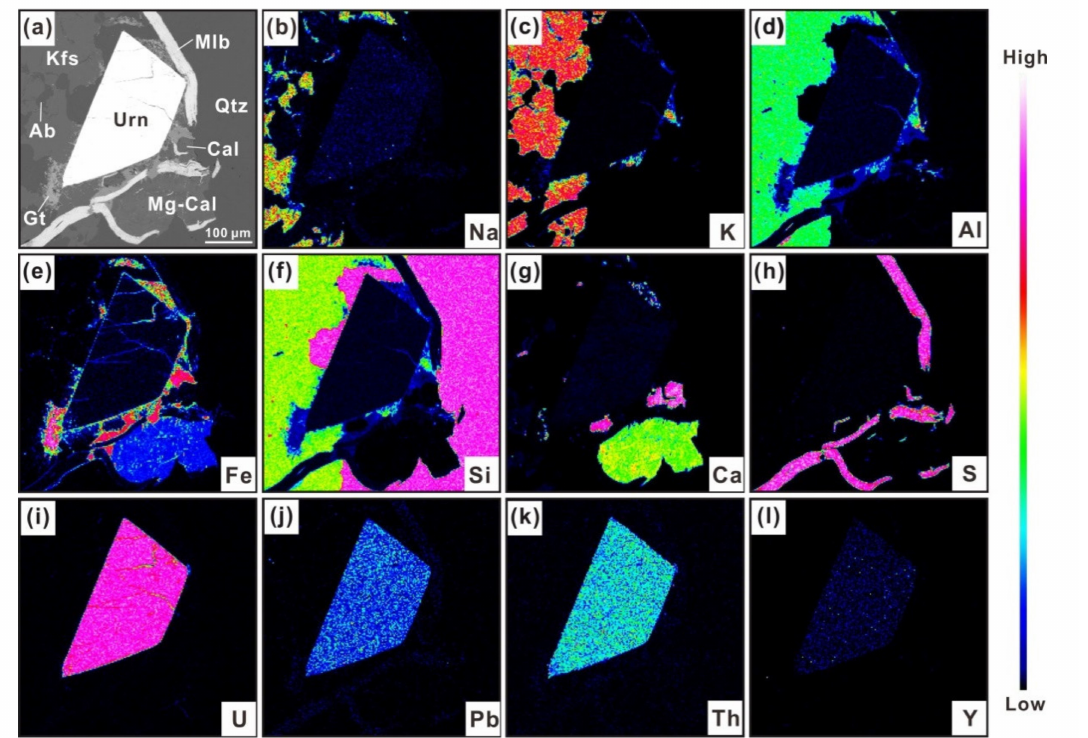
Figure 4. ( a ) Backscattered electron image showing the association of molybdenite, calcite and goethite around non-altered uraninite. ( b – l ) X-ray compositional maps of Na, K, Al, Fe, Si, Ca, S, U, Pb, Th and Y in the same area as ( a ). Of note, U, Pb, Th and Y in uraninite are homogeneously distributed and do not show evidence for post-crystallization alteration. Abbreviations: Ab—albite, Cal—calcite, Gt—goethite, Kfs—K-feldspar, Mlb—molybdenite, Qtz—quartz,